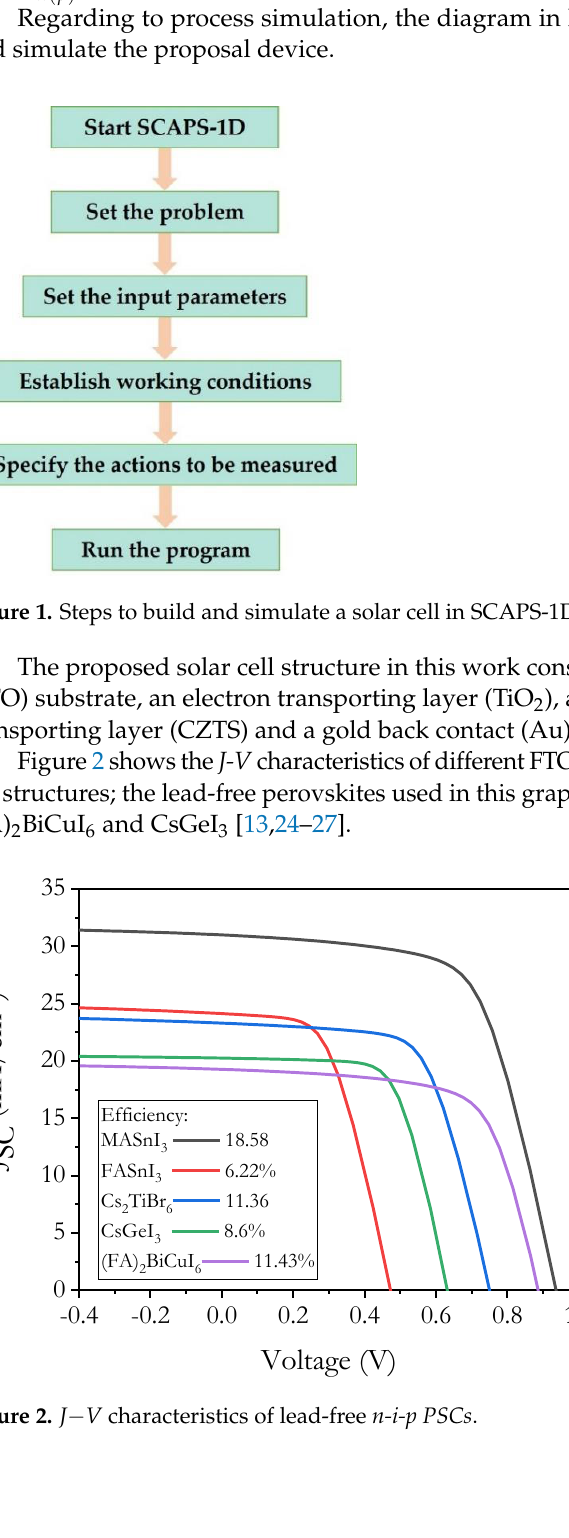
Figure 2. J−V characteristics of lead-free n-i-p PSCs .